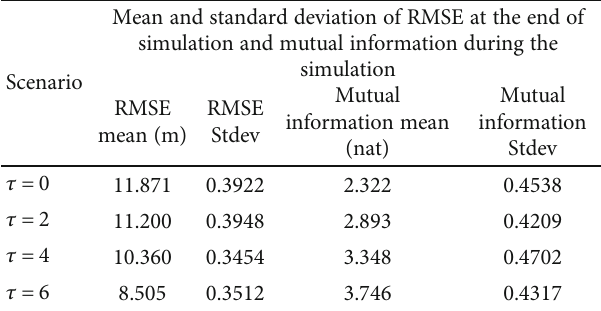
Figure 5: Average RMSE and mutual information of 100 simulation runs. Table 2: Mean and standard deviation of RMSE at the end of simulation and mutual information during the simulation from 100 simulation